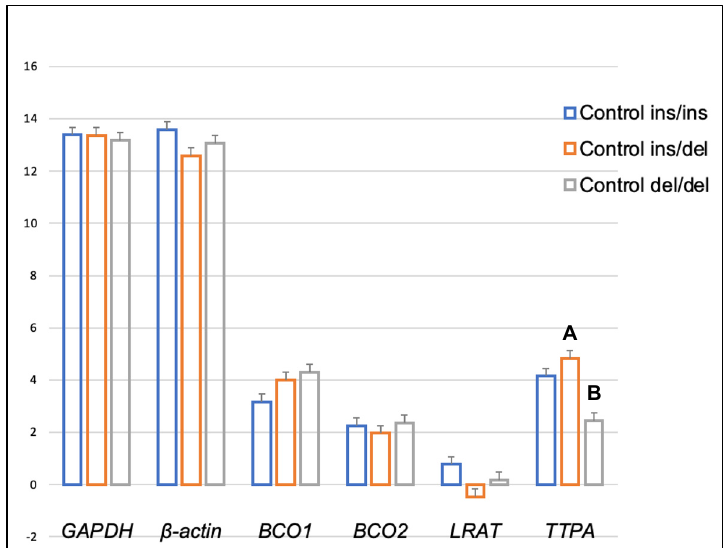
Figure 5. Relative BCO1 , BCO2 , LRAT, and TTPA mRNA levels (log2 abundance) in the brain of rabbits with different genotypes at codon 248 of the BCO2 gene (ins/ins vs. ins/del vs. del/del) fed the control diet. GAPDH and ß-actin were used as reference genes. Data represent posterior means (expressed as arbitrary units) ± SEM (standard error of the mean). Means followed by the different superscripts (A, B) differ highly significantly ( p ≤ 0.01).